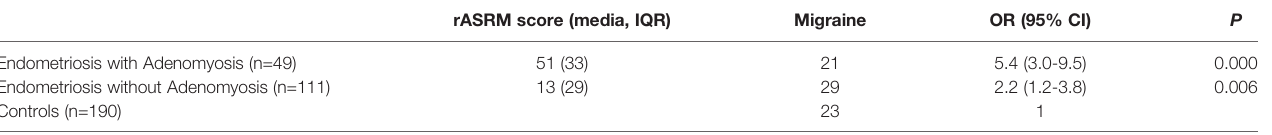
TABLE 4 | Odds ratio(OR) for cases of endometriosis when co-occurring with adenomoysis versus controls according to migraine*. rASRM score (media,